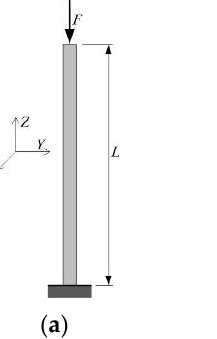
Table 1. Cross-section properties of Examples 1 and 3.